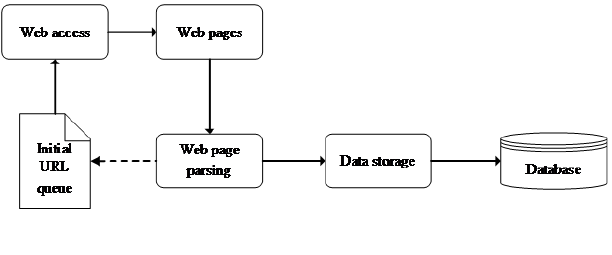
Fig. 3 Crawler structure